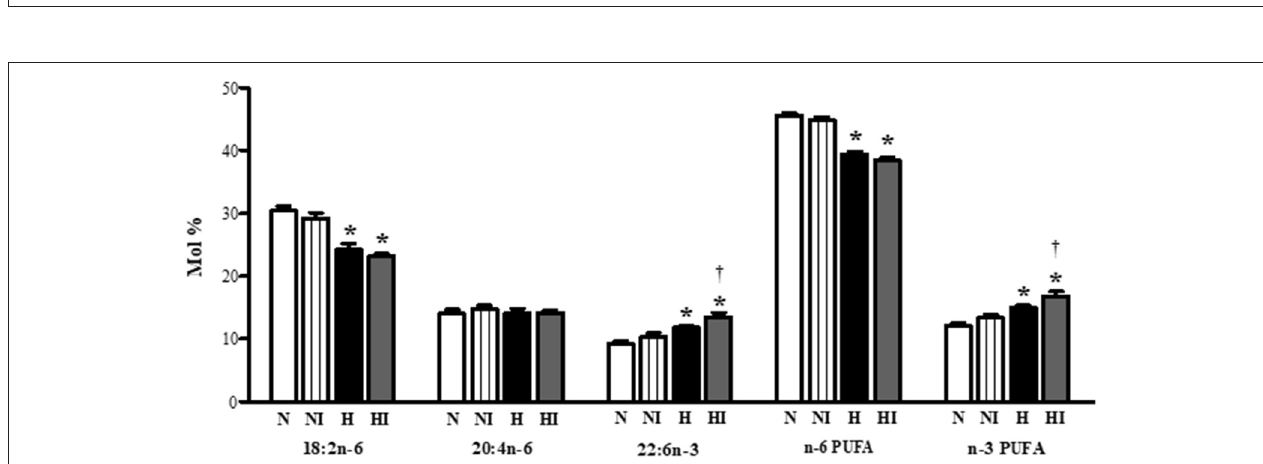
FIGURE 6 | Effect of chronic intermittent hypobaric hypoxia on main polyunsaturated fatty acids [linoleic acid (18:2n − 6), arachidonic acid (20:4n − 6), docosahexaeonic acid (22:6n − 3)], total n − 6 PUFA and total n − 3 PUFA proportion in total phospholipids in the left ventricular myocardium of normoxic (N) and hypoxic (H) rats under control (non-ischemic) conditions and after 10-min regional ischemia (NI and HI, respectively. Values are mean ± SEM, ( n = 7 in each group), * P < 0.05 vs. normoxia, † P < 0.05 vs. corresponding control group.